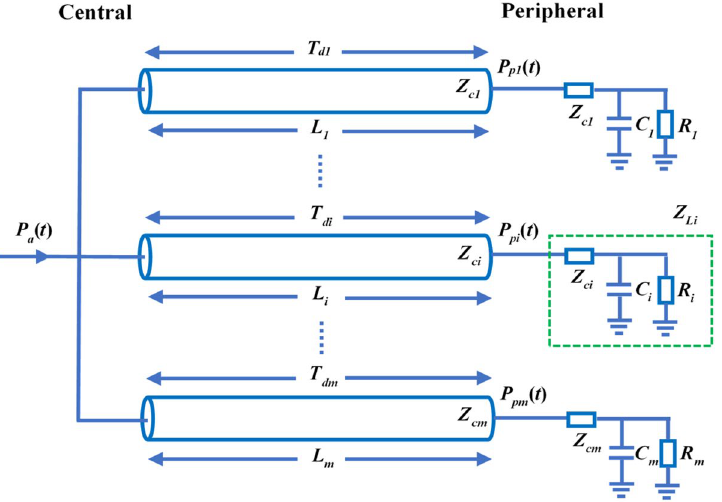
Figure 6. Arterial tube-load model for estimating PTT from the aorta to peripheral arteries. The i th tube ( i = 1 ,…, m ) represents the wave travel path between the aorta and the i th peripheral artery. The terminal load Z Li consists of characteristic impedance Z ci , resistance R i and compliance C i . The PTT and the travel distance between the aortic P a ( t ) and peripheral P pi ( t ) pressure waveforms are defined as the time delay T di and the vessel length L i , respectively. T dm , L m and P pm ( t ) represent the time delay, vessel length and peripheral pressure in the m th tube, respectively. Z cm , C m and R m represent the characteristic impedance, compliance and resistance in the m th terminal load, respectively.